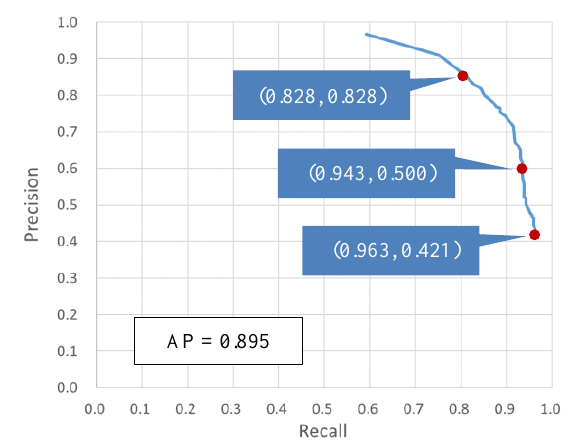
Figure 6. Precision-Recall curves (IoU > 0.7)